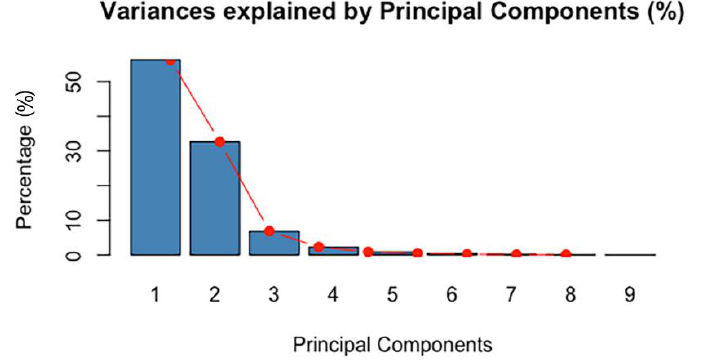
Figure 11. Variance percentage accounted for by the main components for the data in the IR spec- trum.